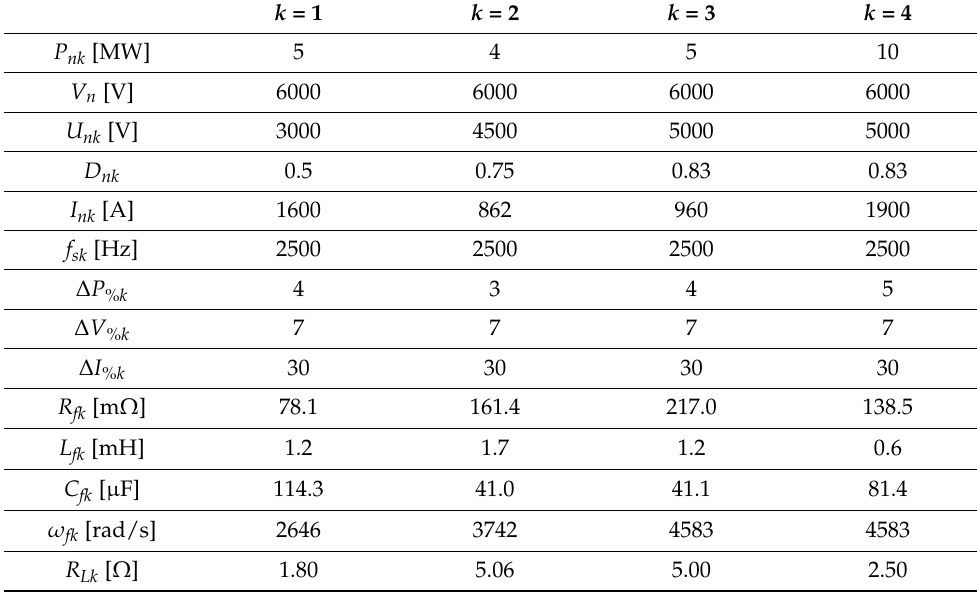
Table 1. Parameters for modeling the load